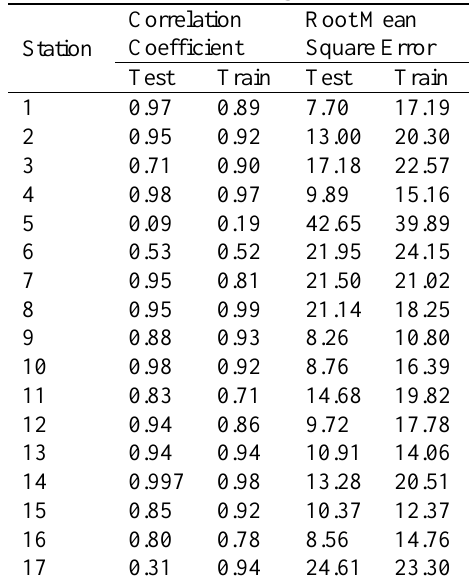
Table 3. The results of the study and verification CARMA model in modeling EC values